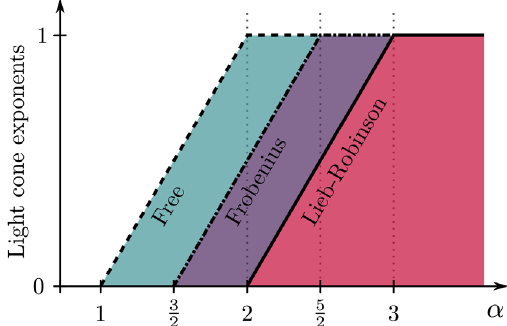
FIG. 1. The hierarchy of linear light cones in one dimension; we say that a light cone has exponent γ if k½ A 0 ð t Þ ; B is large r (cid:2)k only when t ≳ r γ . The plot depicts the exponents of the Lieb- Robinson light cone (solid line) [21], the Frobenius light cone from Theorem 7 (dot-dashed line), and the free light cone from Theorem 9 (dashed line) as functions of α in one dimension. The free light cone is known to be a tight bound for all α . We also show that the Lieb-Robinson and Frobenius light cones are not linear below α ¼ 3 and α ¼ 5 , 2